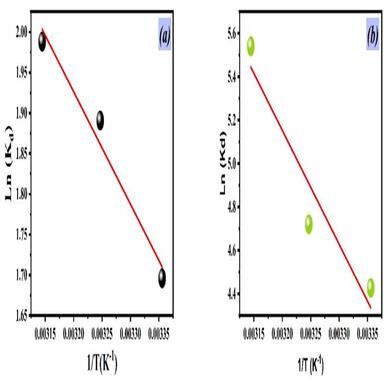
Thermodynamic plot for Bio-HAp (a) and Bio-HAp@PPy nanocomposite nanocomposite(b).